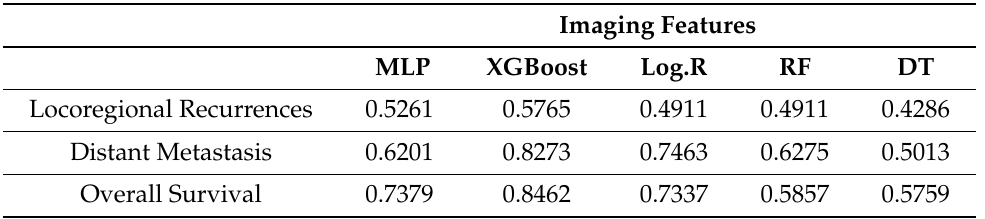
Table 1. Global results (AUC values) of Locoregional Recurrence (LR), Distant Metastasis (DM) and Overall Survival (OS) predictions for the imaging features’ models.